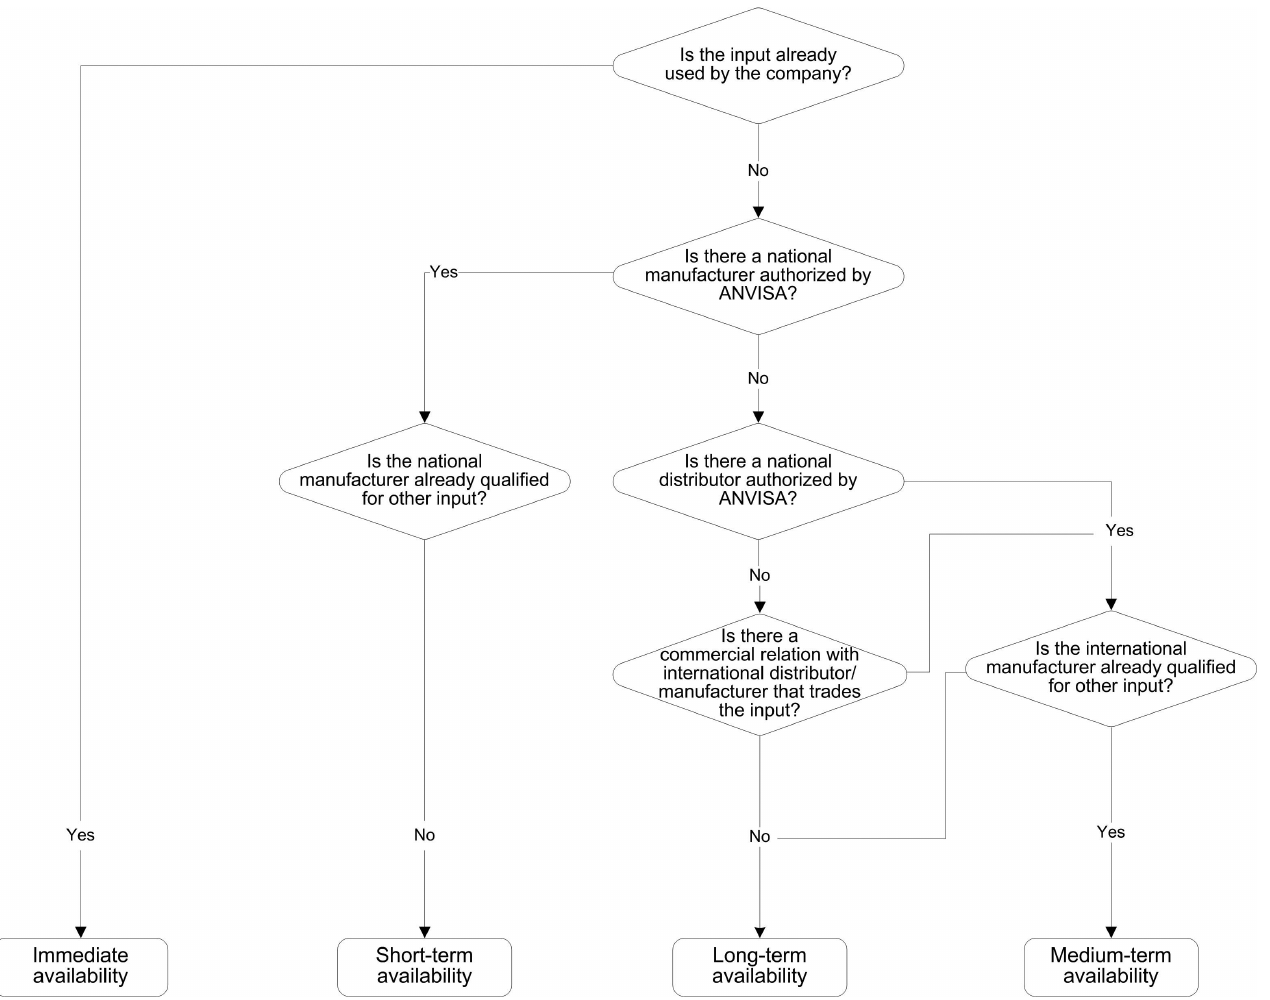
FIGURE 8 – Decision tree for evaluation of raw material